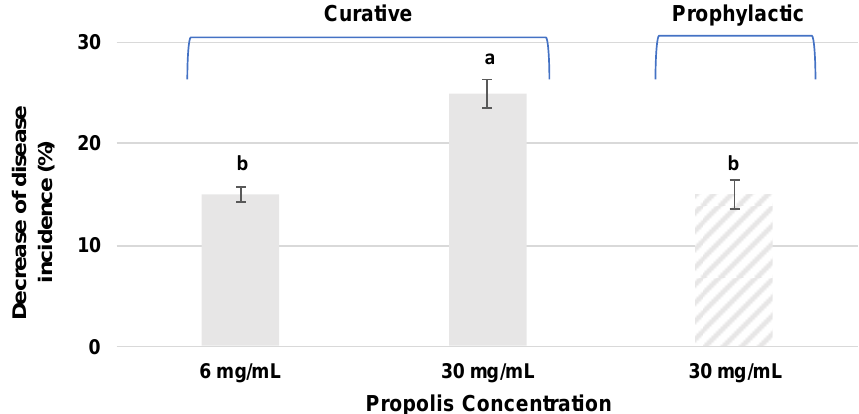
Figure 3. Decrease of the disease incidence relative to control after 14 days of incubation at 20 °C in the curative (left) and prophylactic (right) assays. Results are presented as means ± standard deviation of two replicates Different letters denote significant differences among the decrease of disease incidence relative to control ( p < 0.05).